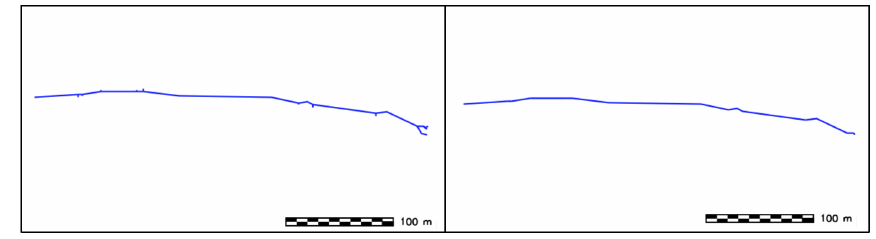
Figure 13. SWC smoothing.